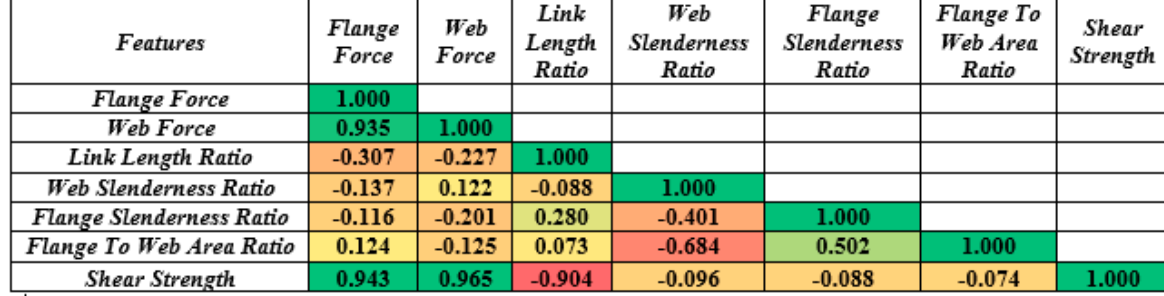
Figure 7. Correlation matrix analysis.